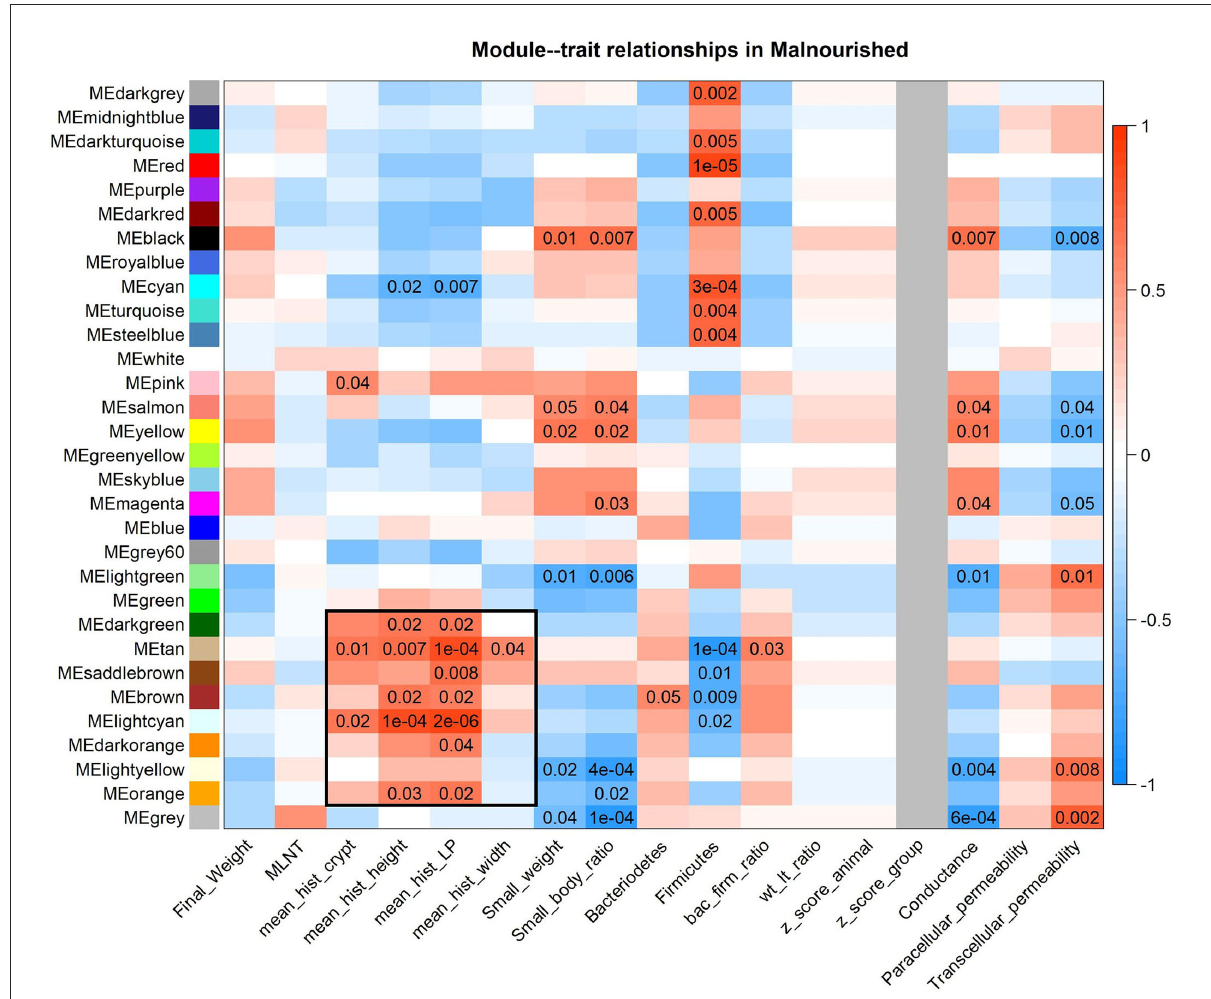
FIGURE6 Heatmap of consensus modules-malnourished traits relationships. Consensus modules (clusters of co-expressed genes) made with samples from both the FF and Mal groups are identified as colors on the Y-axis and traits from Mal animals are on the X-axis. P -values of < 0.05 are displayed in the heatmap, color indicative of positive (red) or negative (blue) correlation between gene module and phenotype. The block of modules associated with the histological data is highlighted with a black